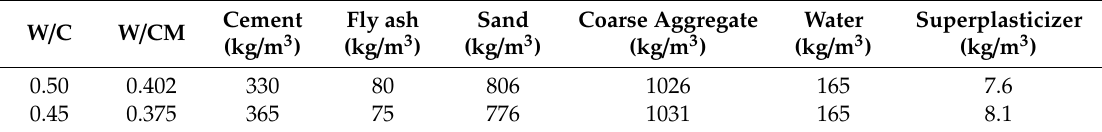
Table 6. Mixing ratio of concrete